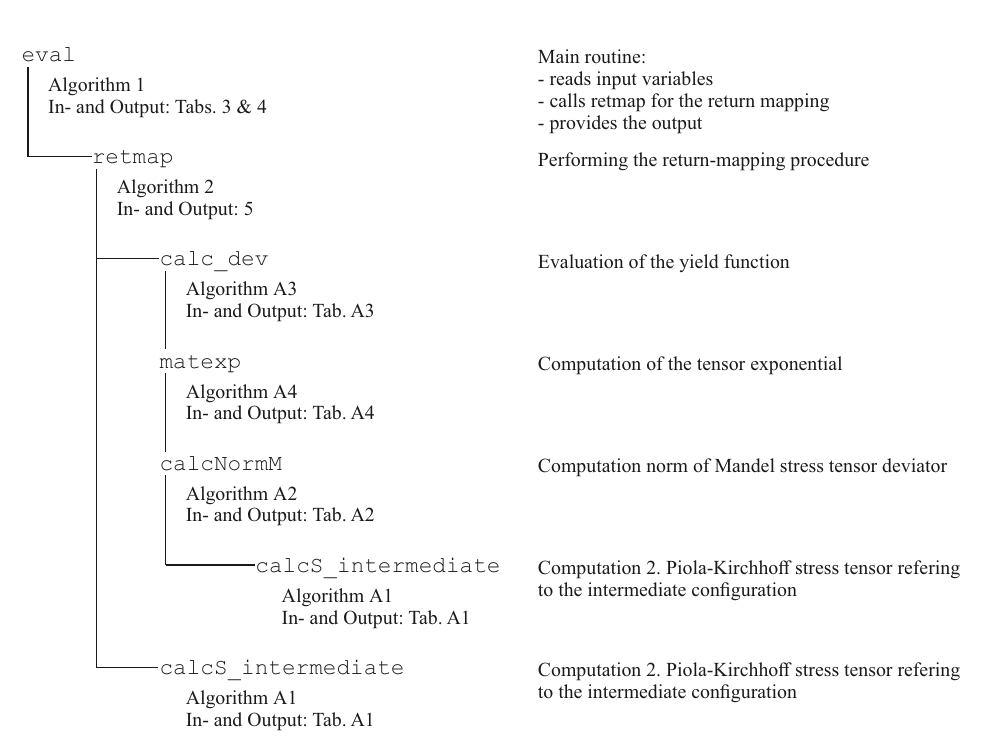
Algorithm 1 Main routine implemented in COMSOL Multiphysics for the calculation of 𝐒 and 𝐉